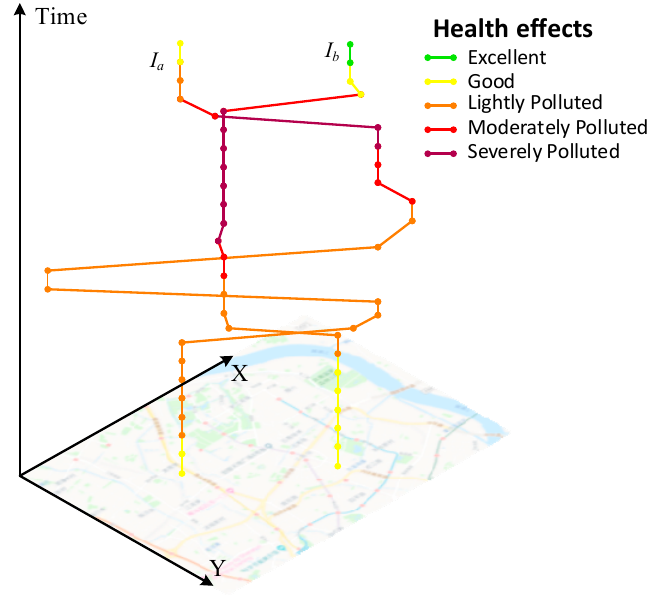
Figure 11. Illustration of individual exposure-level trajectories.